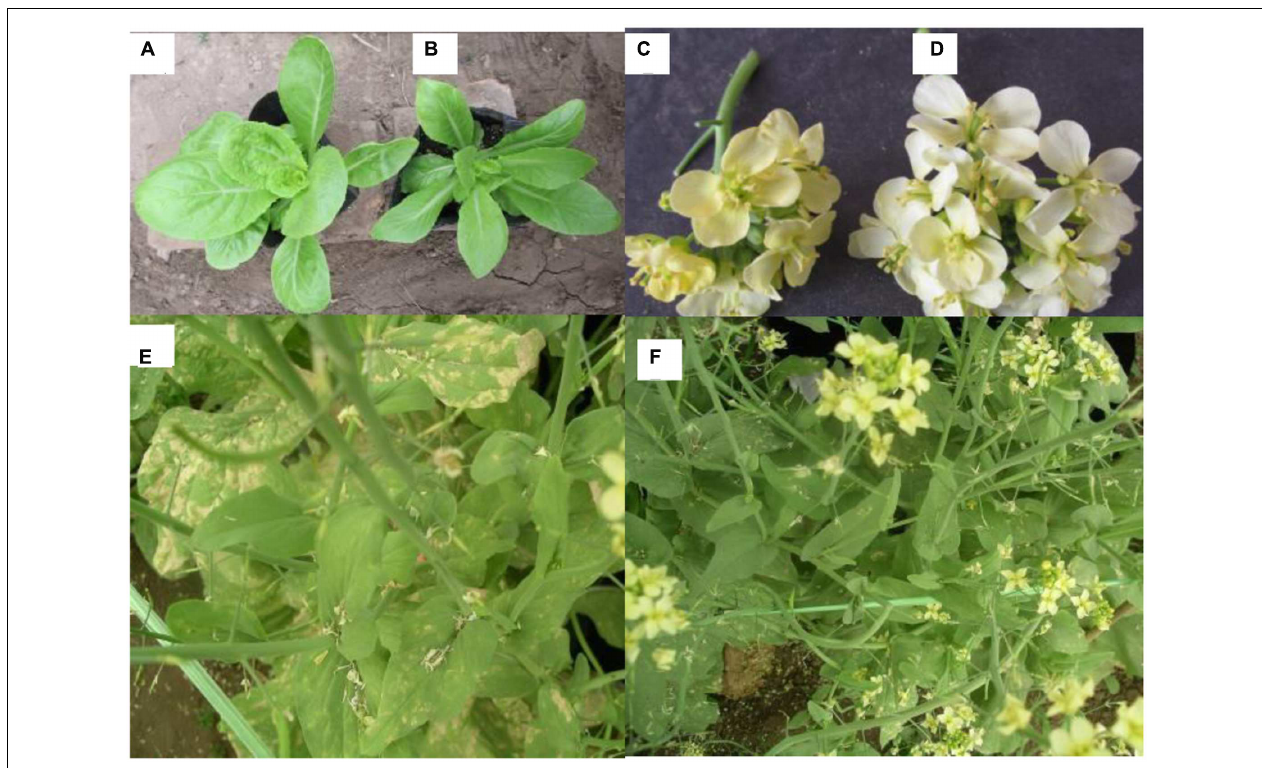
FIGURE 2 | Phenotypic changes of mutants in the M 1 generation of the Chinese cabbage after soaking buds with EMS (A) Wild type A03. (B) A03 leaf shape variation mutant (blade tip of mutants was slightly pointed). (C) 85-1 flower color variation mutant (yellowish color). (D,E) Wild type 85-1. (F) 85-1 tolerance to downy mildew